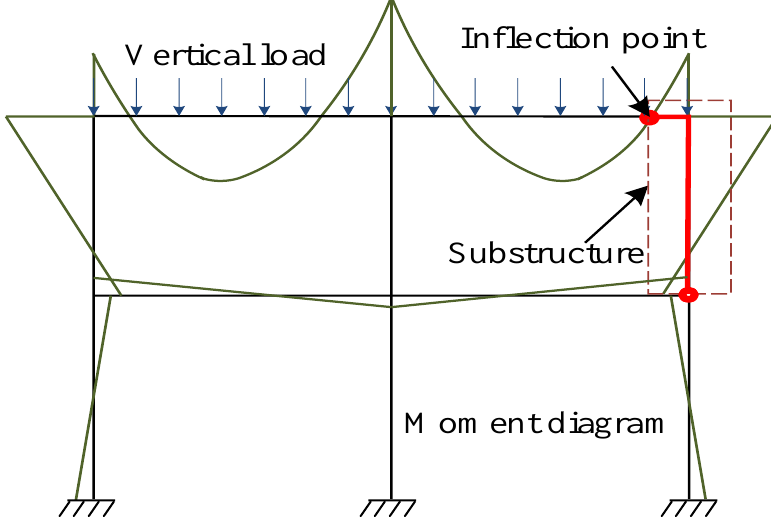
Figure 3. Simplified model of a cross-section of the subway station.